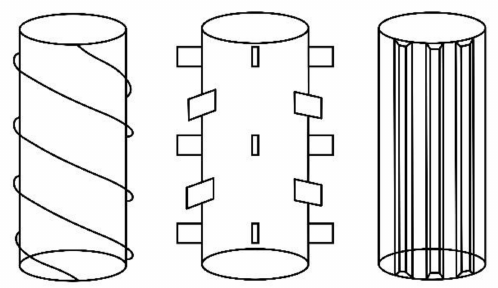
Figure 2. Vortex-disturbing devices: (from ( left ) to ( right )) strakes, spoilers, and